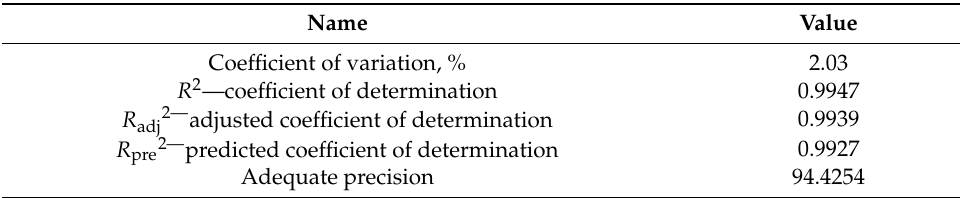
Table 4. Regression